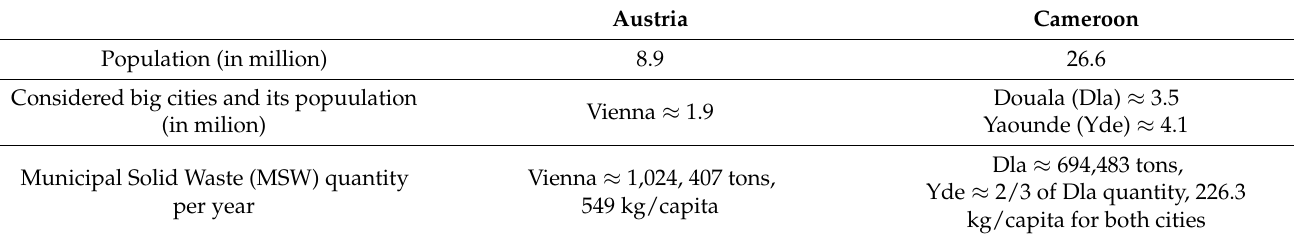
Table 7. Overview of the survey and the research